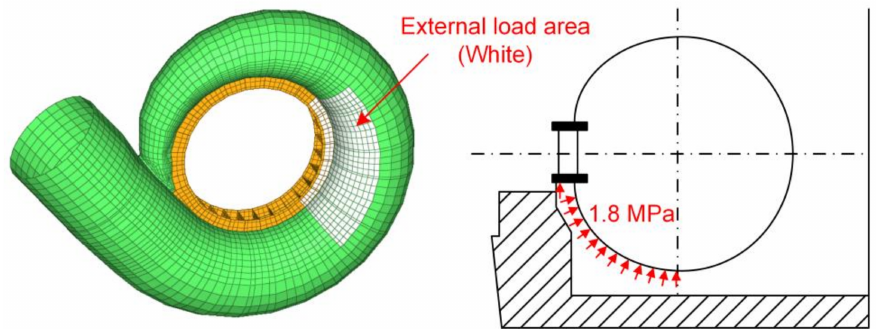
Figure 8. External load.